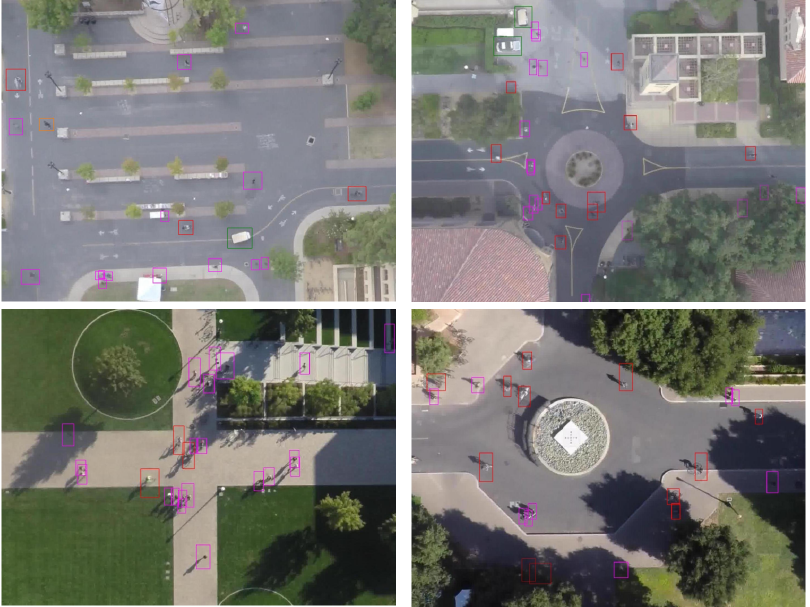
Figure 1. Objects in UAV images are usually small in size (proportional to total image size) and general purpose object detectors are not designed to cope with it